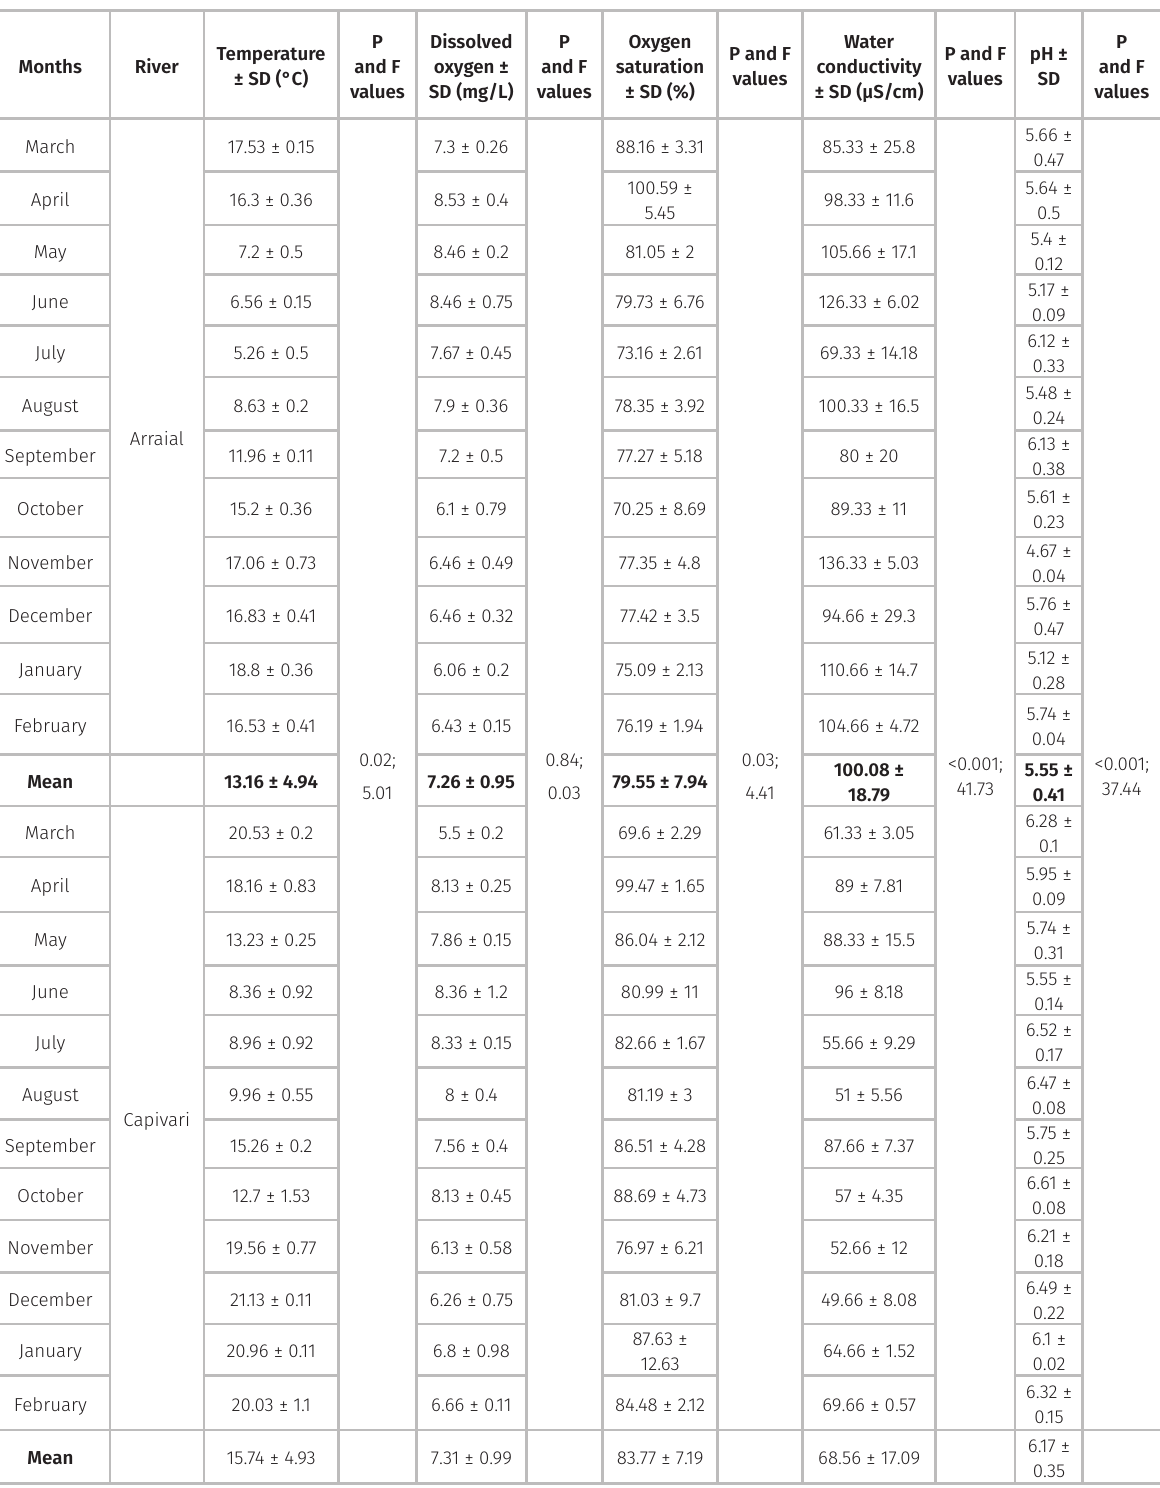
Table I. ANOVA results and mean values for temperature, dissolved oxygen, oxygen saturation, water conductivity and hydrogen potential (pH) comparison among Arraial and Capivari